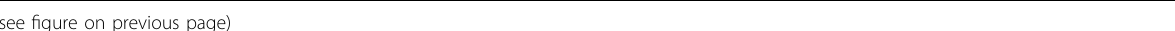
Fig. 2 MAbs binding and neutralization of diverse SARS-CoV-2 variants. a Key substitutions in RBD in 19 previous and current variants. b Neutralization activity of the indicated antibodies against the SARS-CoV-2 variants examined in human Huh7 cells using a pseudovirus system. “ / ” : These antibodies show low neutralization activity against BA.1 and BA.2, therefore no further research against other Omicron variants were performed. c K D values of the indicated antibodies to RBD of various variants examined by SPR. Data were collected from two biological replicates and represented as means ± SD. d Competitive binding of the antibodies in BLI-based competitive binding assay. Inhibitory rate was shown as a percentage. Antibody A displaying > 50% inhibitory rate against antibody B means antibody A strongly competes with antibody B to bind the RBD. e Neutralizing titer IC 50 values of the indicated antibodies against the authentic SARS-CoV-2 variants in FRNT assays. “ / ” : These antibodies show low